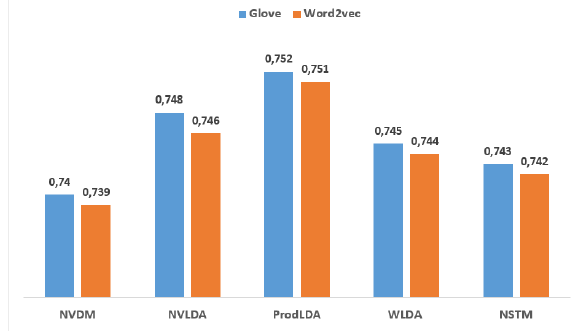
Figure 5. The NPMI of the compared models for the French dataset.